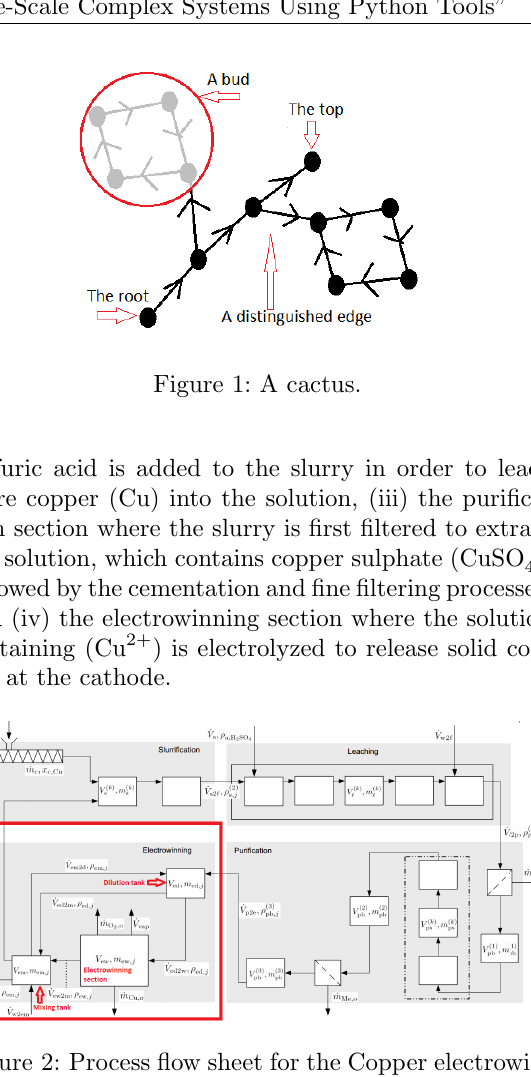
Figure 2: Process flow sheet for the Copper electrowin- ning process (electrowinning section is high- lighted in